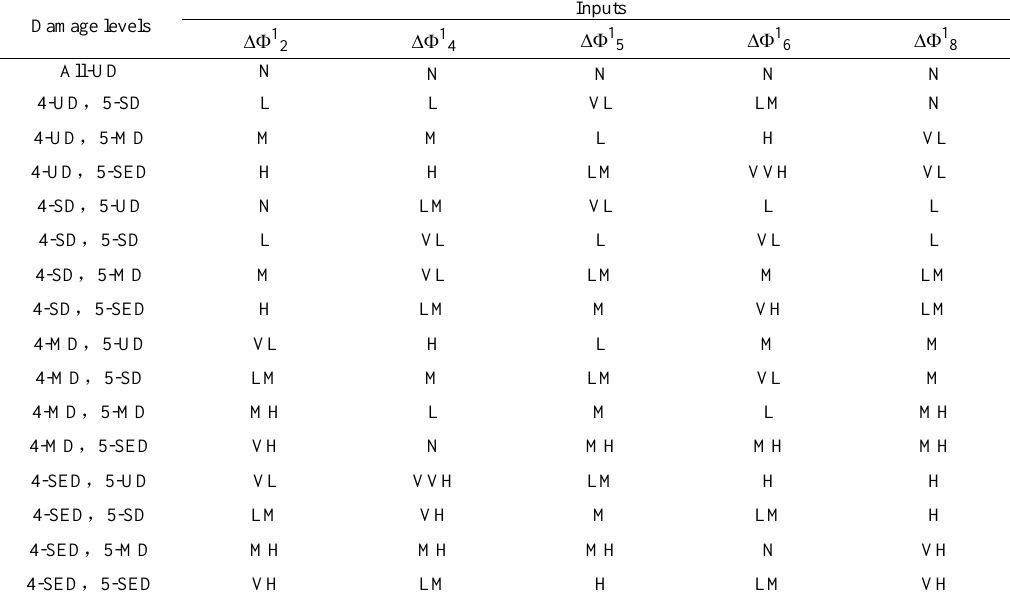
Table 9 Fuzzy rules of case 3